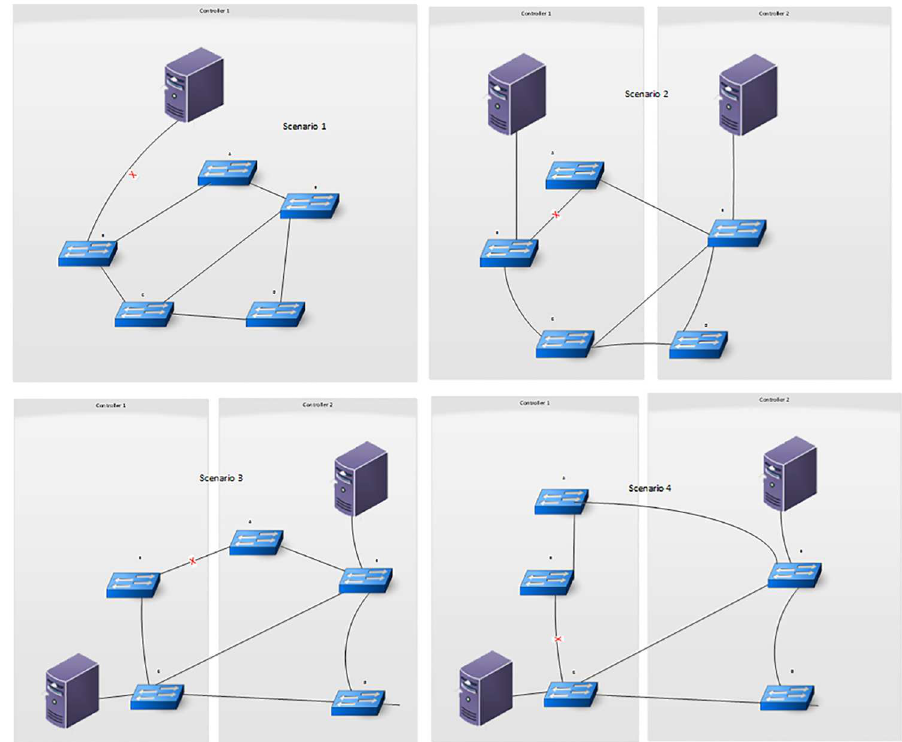
Fig 2. Illustrated controller placement